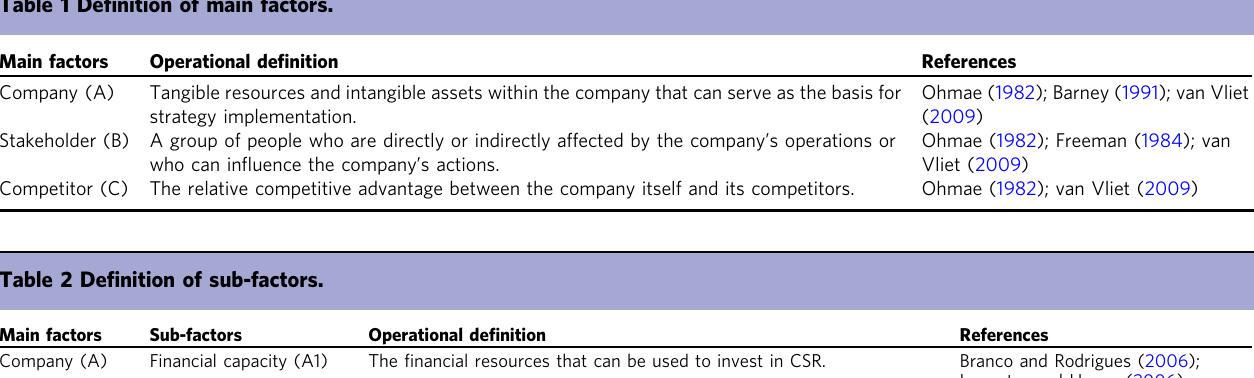
Table 1 De fi nition of main factors.